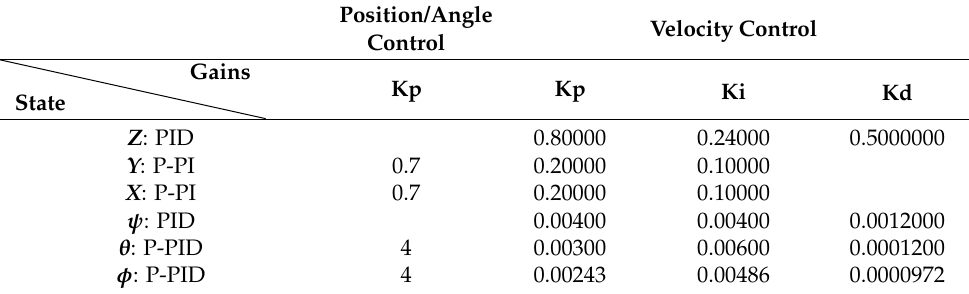
Table 2. PID gains parameter.